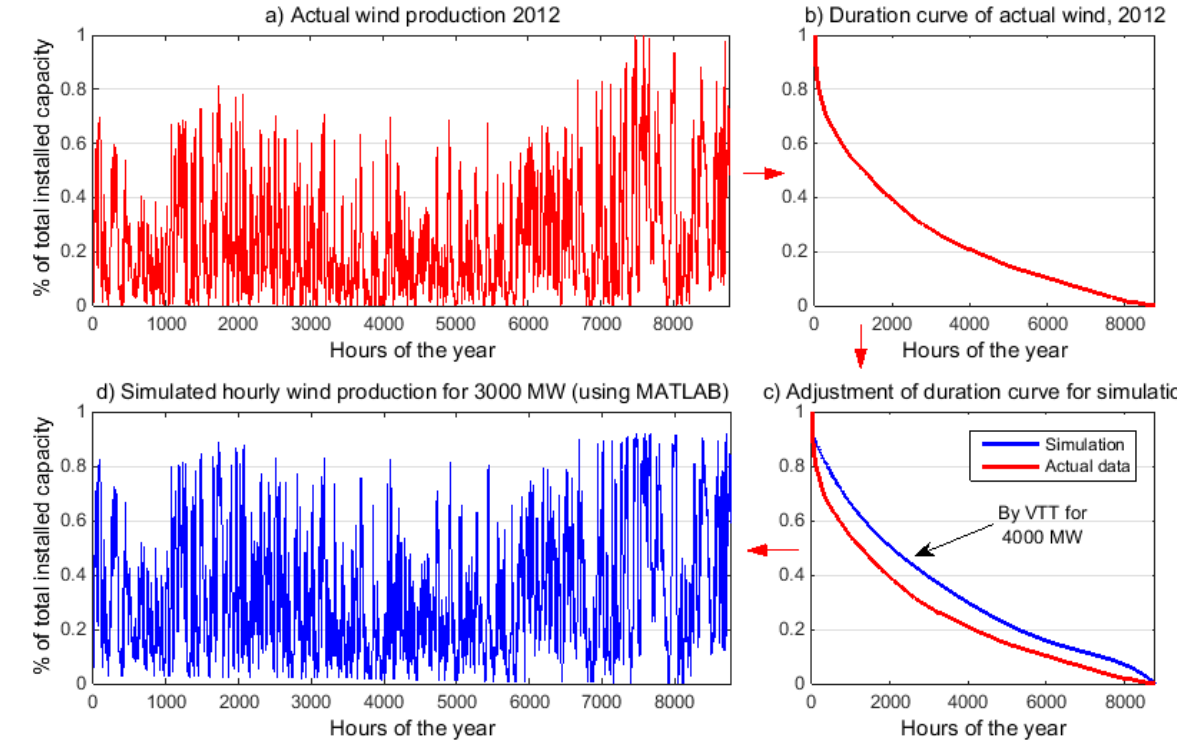
Figure 2. Methodology in modeling and simulation of large-scale wind integrations in four steps: ( a ) Actual wind distribution in 2012; ( b ) Actual duration curve; ( c ) Comparing ( d ) Reproducing hourly variations from duration curve for any desirable installed